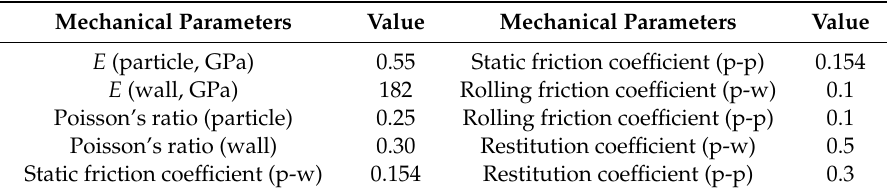
Table 3. Typical mechanical parameters for discrete element method (DEM)